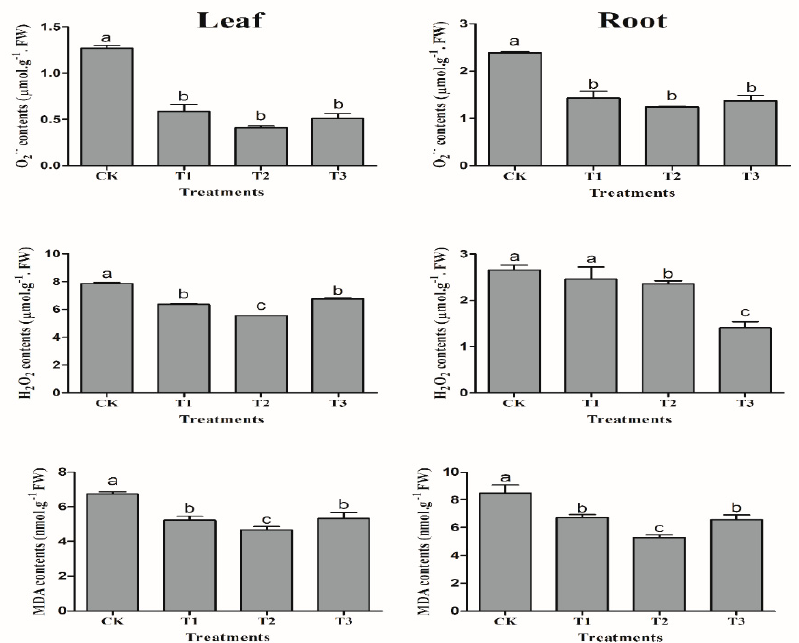
Figure 6. Effect of exogenous ALA application on reactive oxygen species and malondialdehyde contents under low-temperature and weak-light stress in cucumber seedlings. Data are the means of four replicates; error bars indicate the standard deviation. Treatments with the same lower-case letter are not significantly different (least significant difference test, p = 0.05). O 2· − , superoxide radical; H 2 O 2 , hydrogen peroxide; MDA, malondialdehyde.